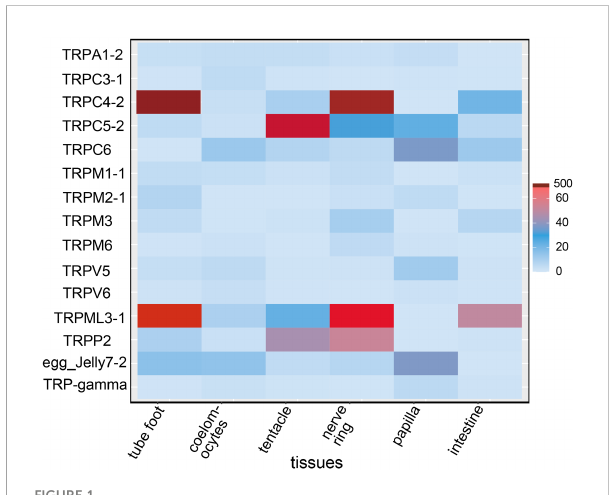
FIGURE 1 The relative expression levels of TRPs in different tissues. Expression pro fi les of TRPs in different tissues including tube foot, coelomocytes, tentacle, nerve ring, papilla, and intestine. Data are presented as the mean ± S.E.M. (n = 5). egg_Jelly: receptor for egg jelly, belonging to the TRPP